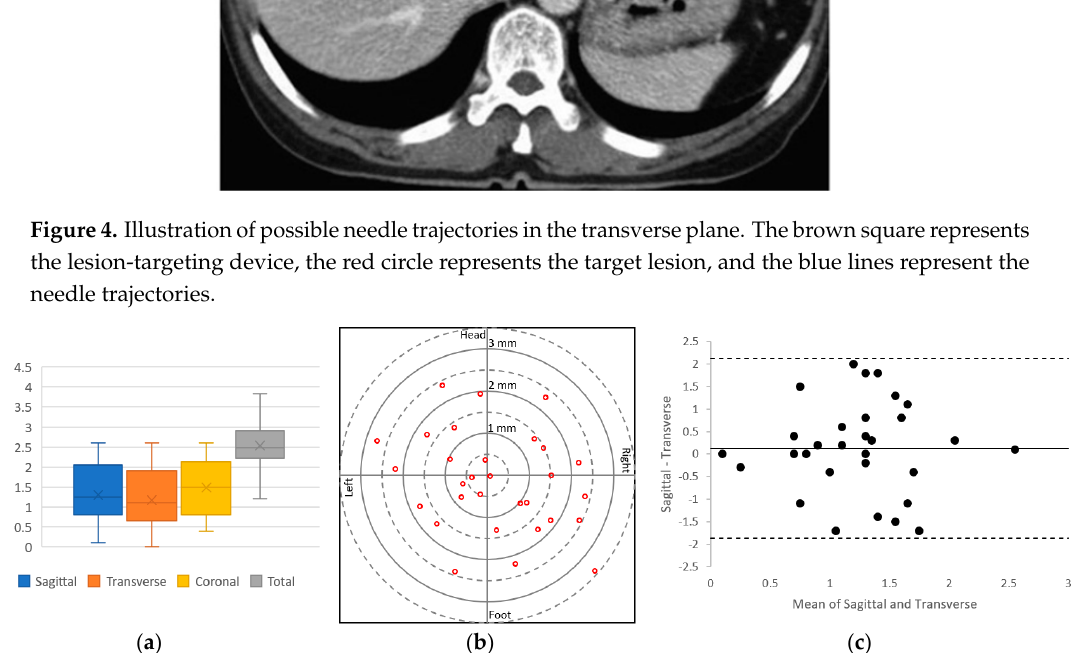
Figure 5. Plots of the lesion-targeting error in phantom studies. ( a ) Quartile plot of sagittal, transverse, coronal, and total targeting error. ( b ) Plot of radial error. Solid rings every millimeter, dashed rings every 0.5 mm. ( c ) Bland–Altman plot of sagittal and transverse error measurements.